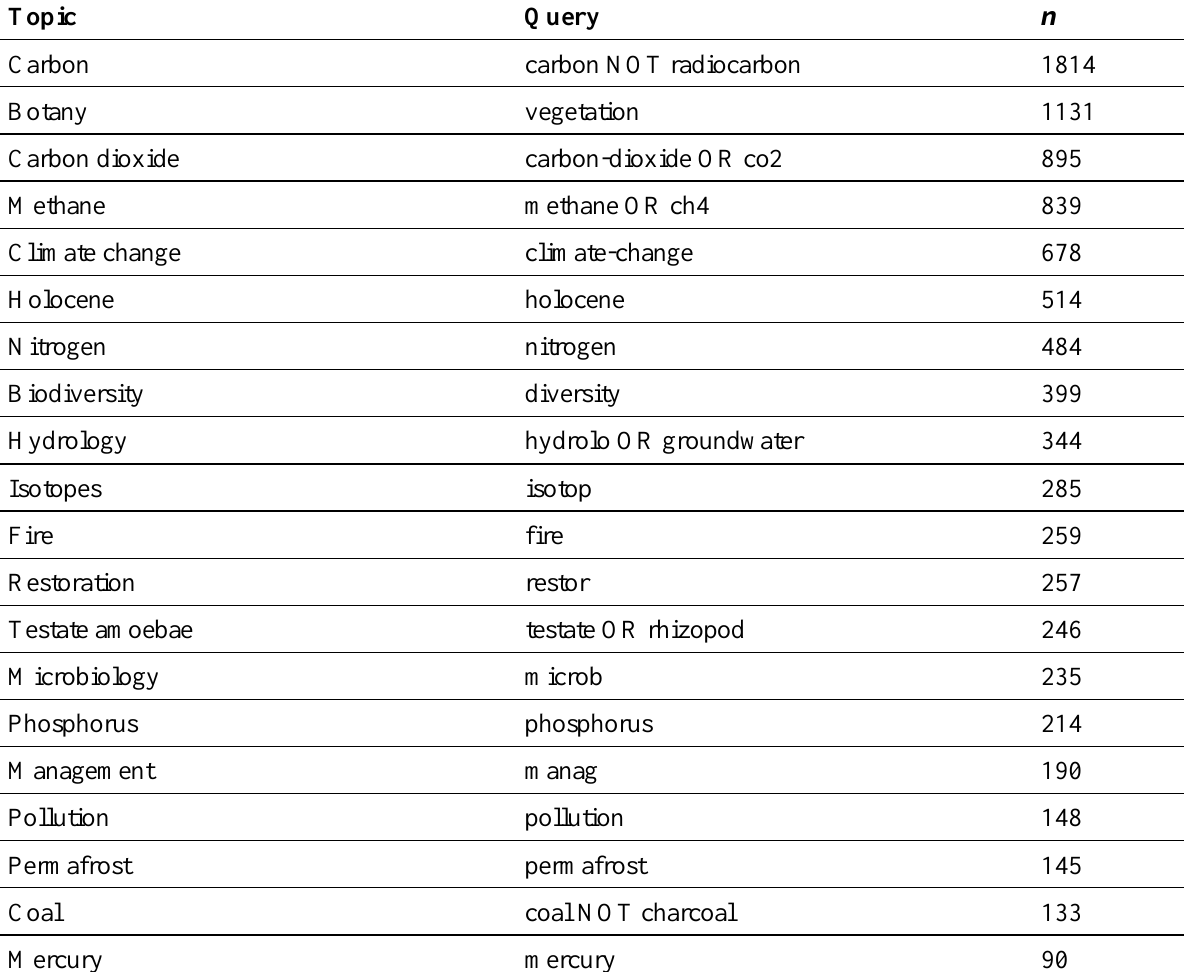
Table 1. Keyword totals, identified as topics, and queries applied for each keyword.